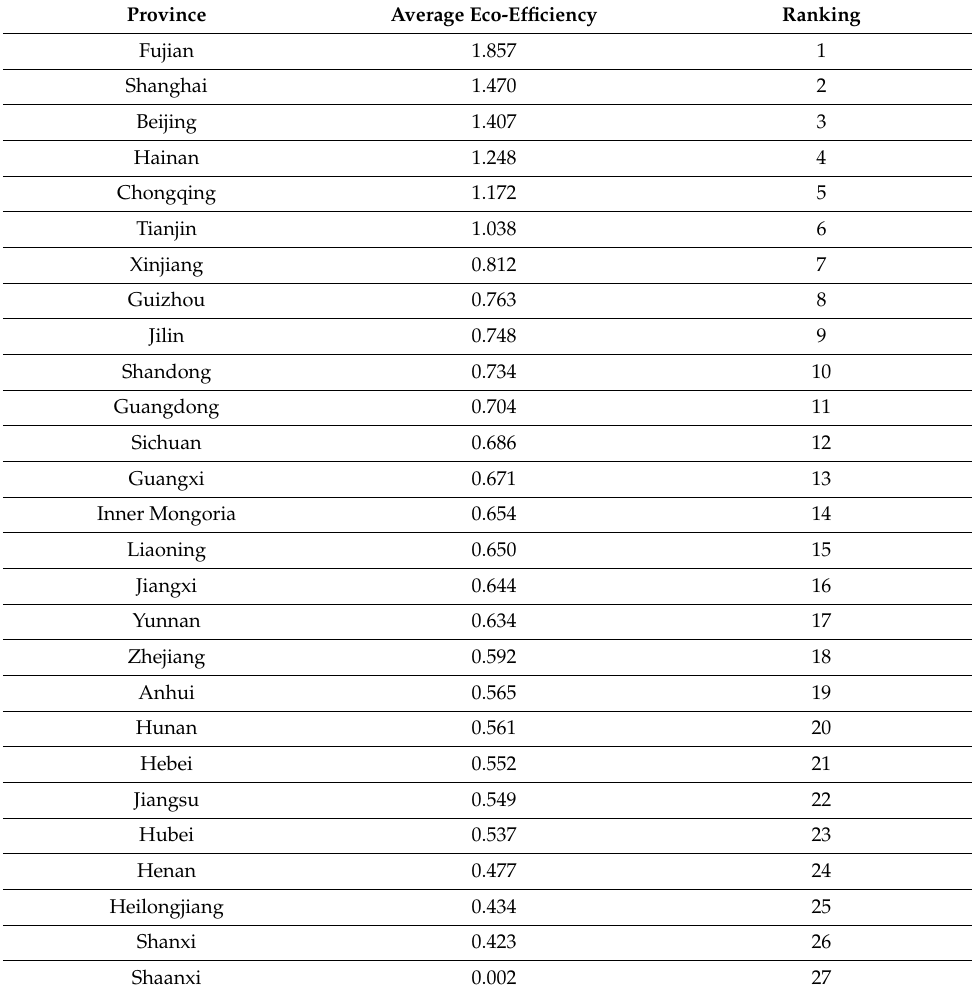
Table 2. Average eco-efficiency for each province from 2003 to